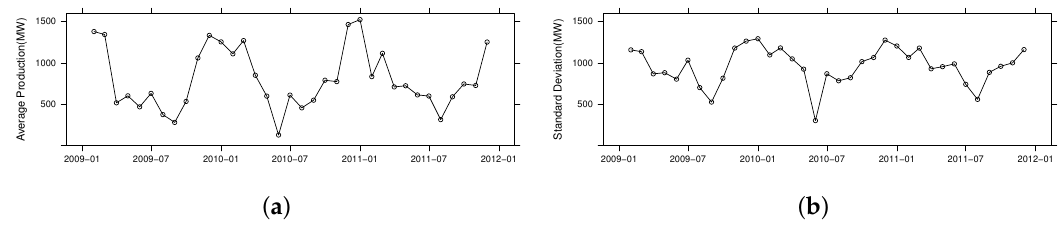
Figure 5. Monthly statistics of wind electricity of the wind farm in Shinan, South Korea. ( a ) average wind electricity; ( b ) standard deviation of wind